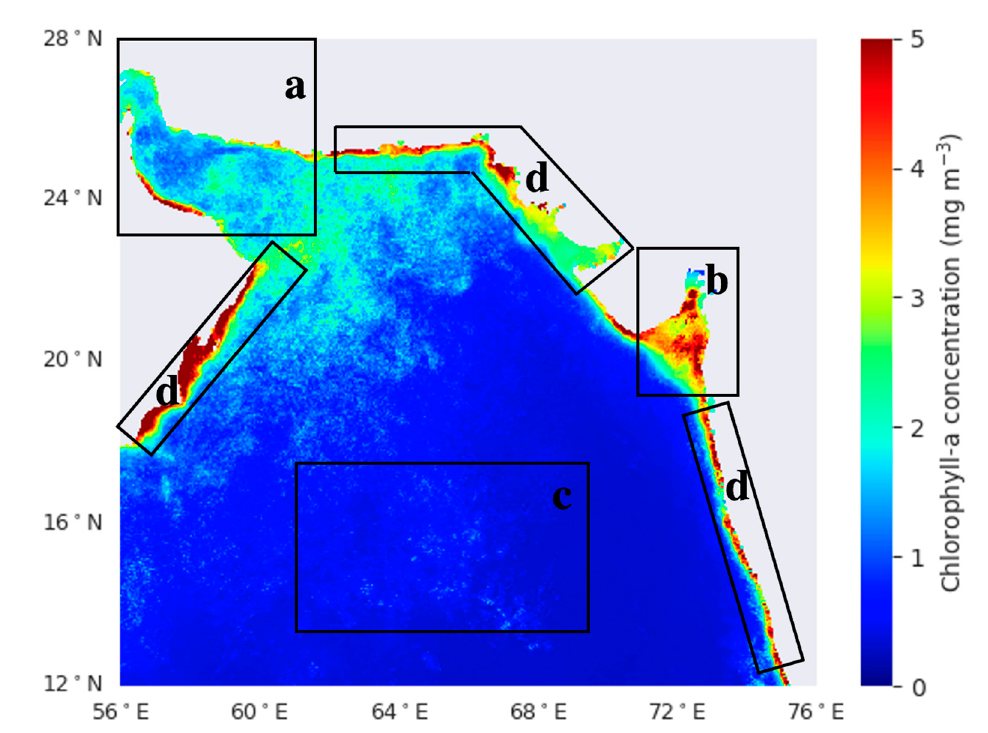
Figure 10. Mean values for the DINCAE − BME reconstruction results in a time series. ( a ) Region representing the Gulf of Oman; ( b ) region representing the Gulf of Khambhat, which is near India; ( c ) region representing the deep − sea region of the NAS; ( d ) region representing the coastal region.